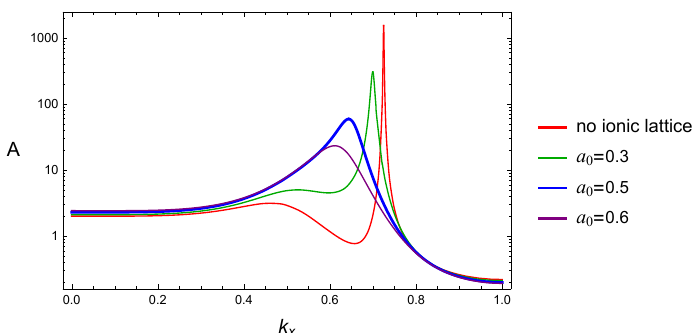
Figure 11 . The MDF along the k x -axis (when k y = 0) for di(cid:11)erent values of the amplitude of the ionic lattice for (cid:12)xed ! = 10 (cid:0) 6 , q = 2 and T = 0 : 01426. The case with a 0 = 0 : 5 is denoted by a thick blue curve. The (cid:12)rst Brillouin zone boundary is at k x = 1. This shows that the inner Fermi surface dissolves as the strength of the ionic lattice